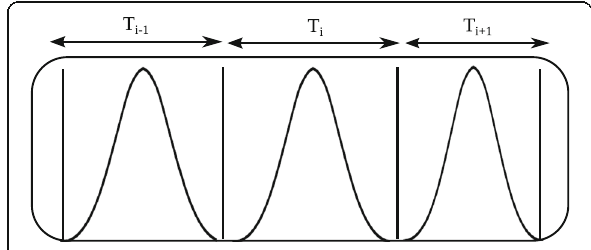
Fig. 1 Absolute jitter measurement for N = 3 pitch